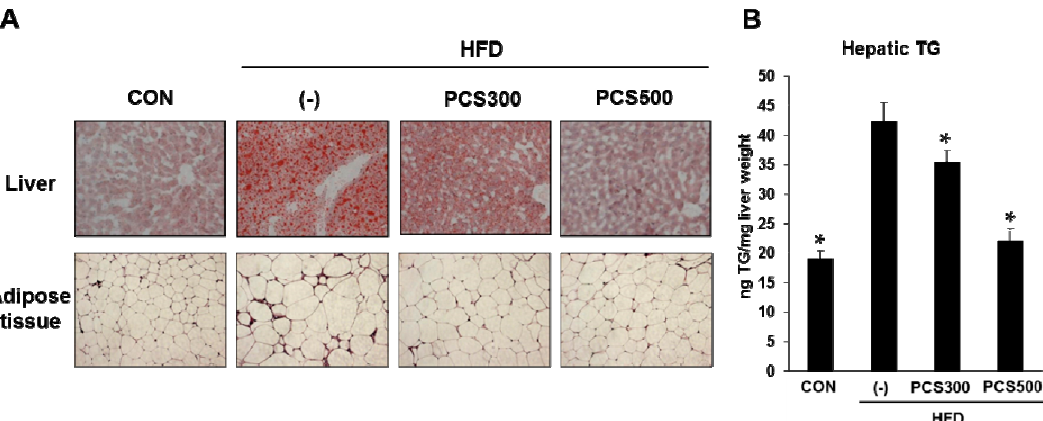
Figure 4. Effect of PCS extract on lipid accumulation in liver and adipose tissues. Mice were fed with regular chow diet (CON) or HFD for 12 weeks. HFD-fed mice were treated with vehicle ( − ) or PCS extract (300 or 500 mg/kg/day) from the first day of HFD feeding ( n = 7–10/group). ( A ) Histology of liver and adipose tissue. Liver sections were stained with Oil red-O and adipose tissue sections were stained with hematoxylin and eosin. Magnification 200×; ( B ) Hepatic triglyceride level (TG). * p < 0.05 vs. vehicle-treated HFD-fed mice.